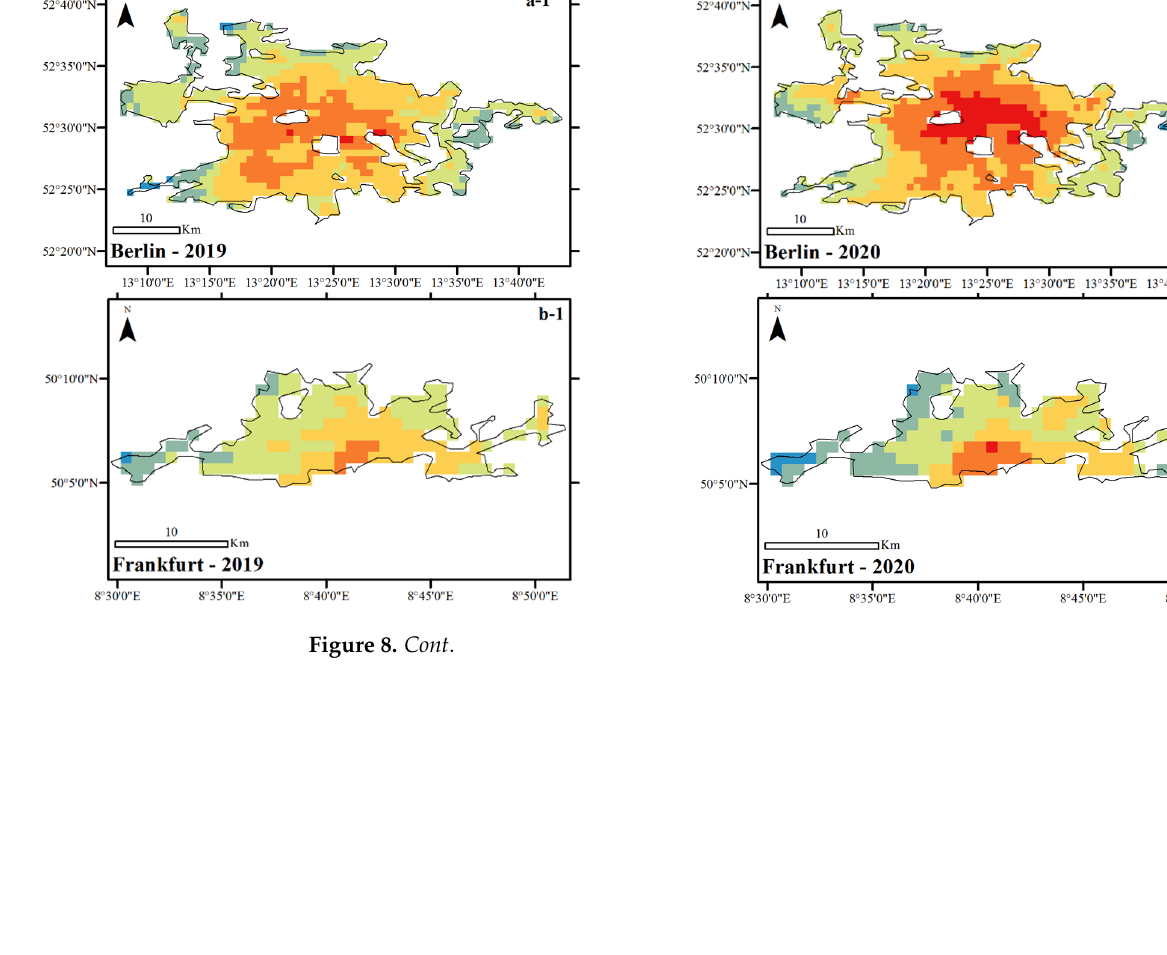
Paired Differences t df Sig. (2- Tailed) Mean Std. Deviation Std. Error Mean 95% Confidence Interval of the Difference